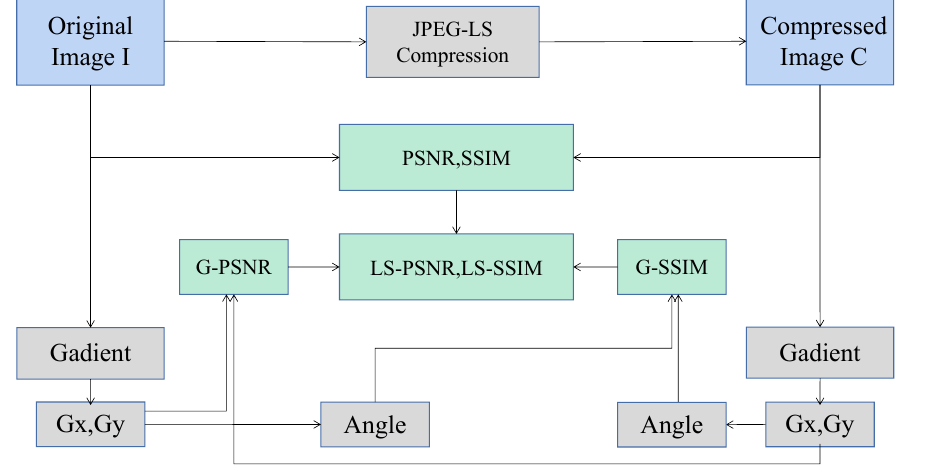
Figure 4. Overview of the proposed LS-PSNR and LS-SSIM. Algorithm 1